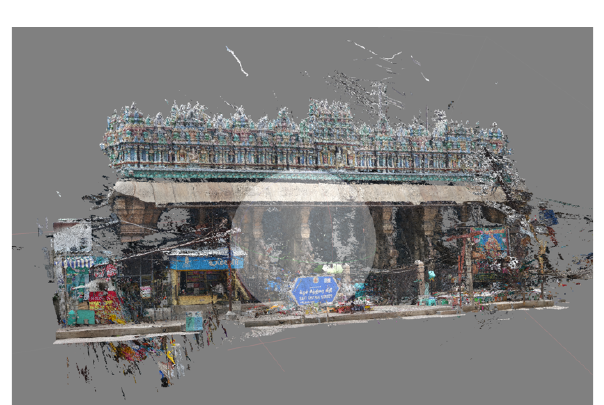
Figure 11. Pointcloud of the West front of the Pudhu Mandapam derived from traditional photogrammetry using © ContextCapture